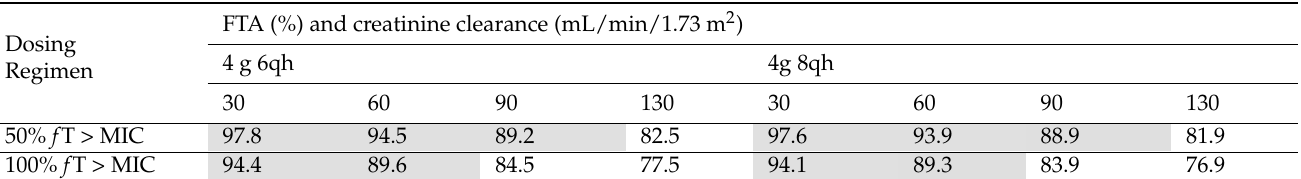
Table 3. Fractional target attainment (FTA) for two piperacillin empiric dosing regimens against the EUCAST MIC distributions P. aeruginosa .